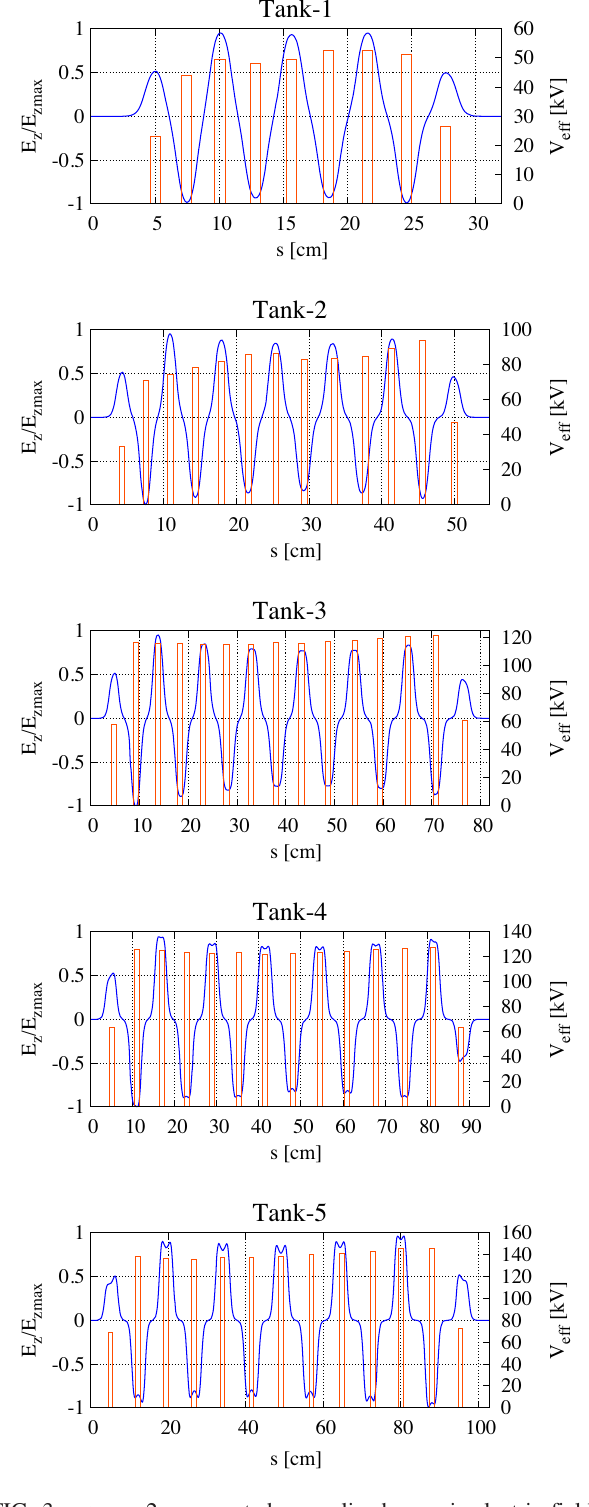
FIG. 3. OPERA 2 D computed normalized on axis electric fields ≔ E s Þ ) for Tanks 1 – 5 of the ISAC-DTL. Note the ( E Z =E max n ð nonflatness of the peak electric field intensity across the cavities. Gap effective voltages for an 14 N 3 þ beam are shown as histo- grams.